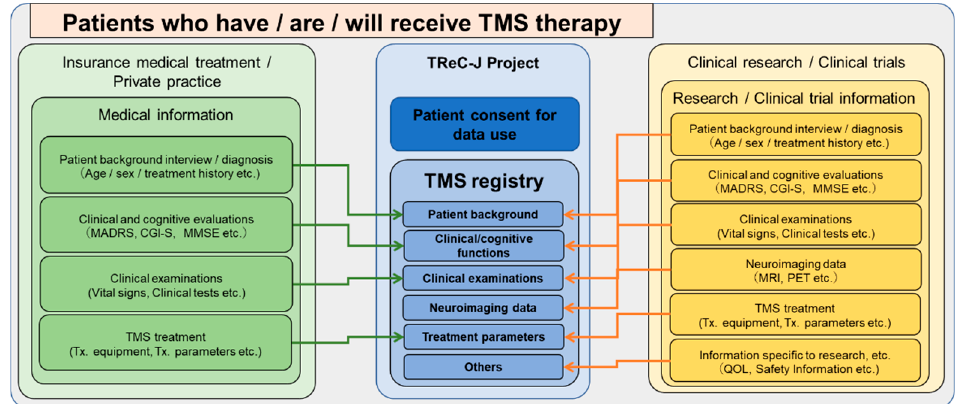
Figure 2. The general framework of the various data attributes and datasets stored in the TMS Registry. This TMS registry is designed to allow the registration of TMS-therapy-related data in both prospective and retrospective fashion within a variety of frameworks, such as insurance medical care, private practice, clinical research, and post-marketing